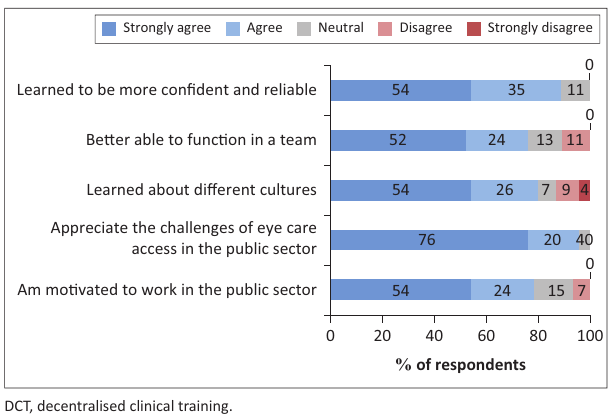
FIGURE 5: Perceptions on their personal growth following decentralised clinical training rotations. TABLE 2: Perspectives of other aspects of decentralised clinical training (percentage of respondents). Other